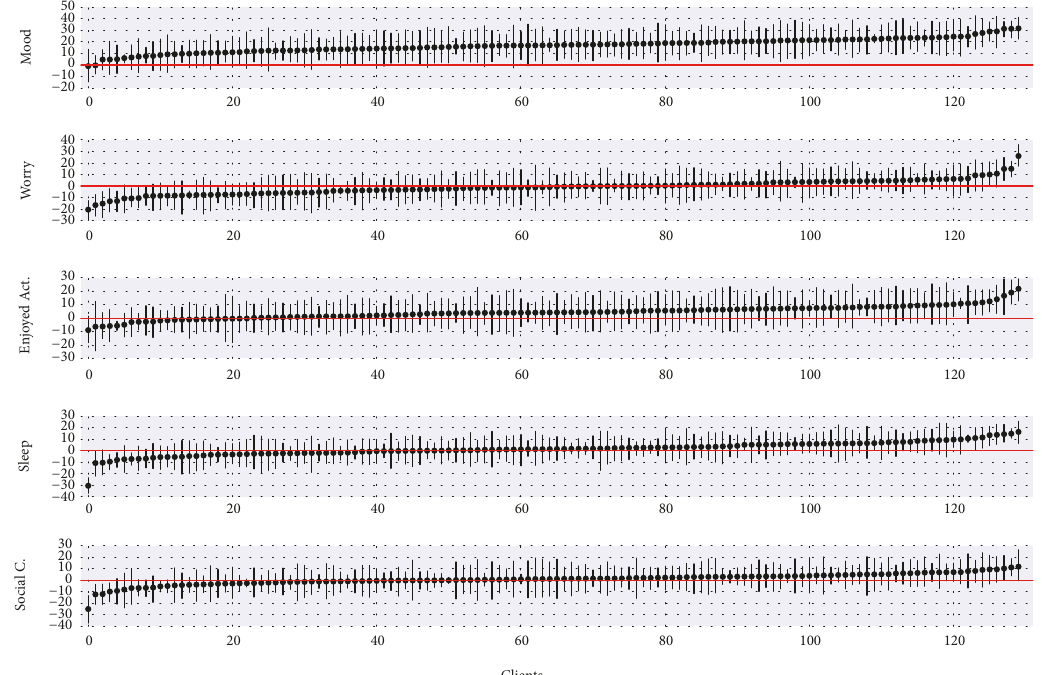
Figure 4: Graphic visualization of parameter distribution for each